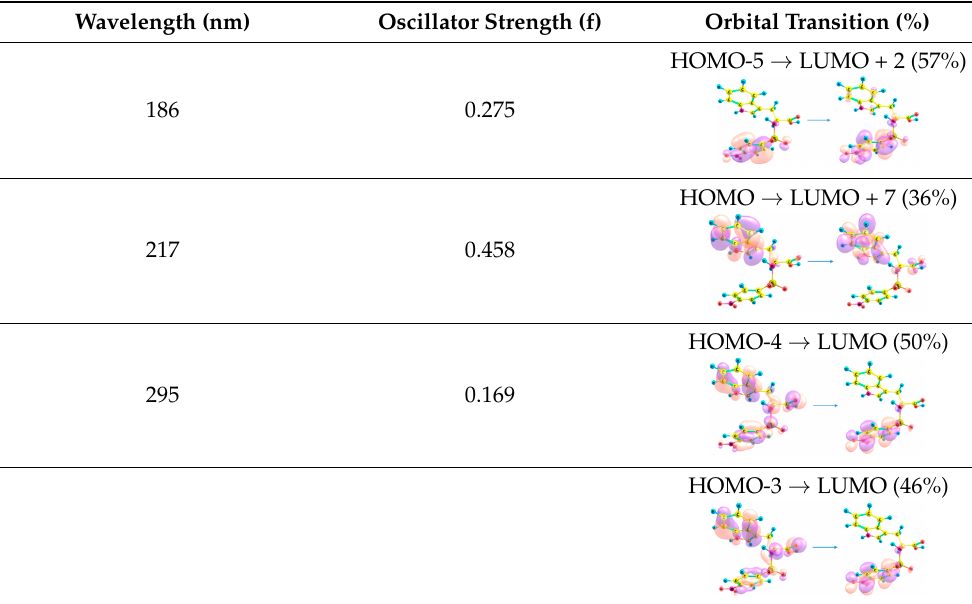
Table 2. Selected computed wavelength (nm), oscillator strength (f), and main orbital transition contributions ( ≥ 20%) of the absorption spectra of DNSPA.